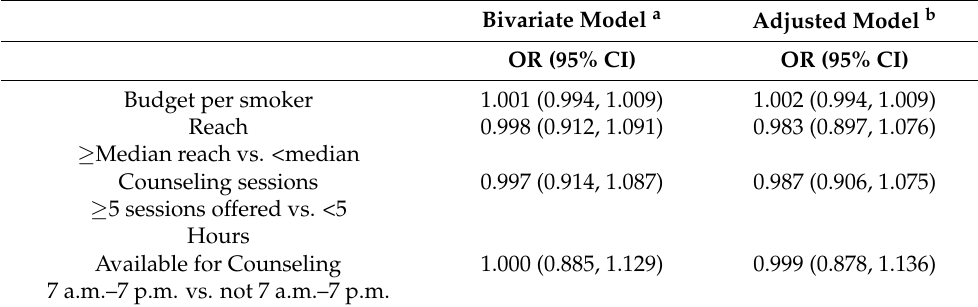
Table A1. Odds ratios for 90-day smoking cessation associated with quitline exposure variables in the sample of year-ago smokers who had made a quit attempt.